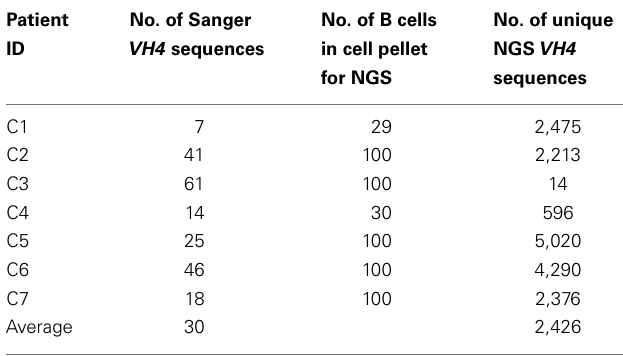
Table 2 | Sequence database size summary